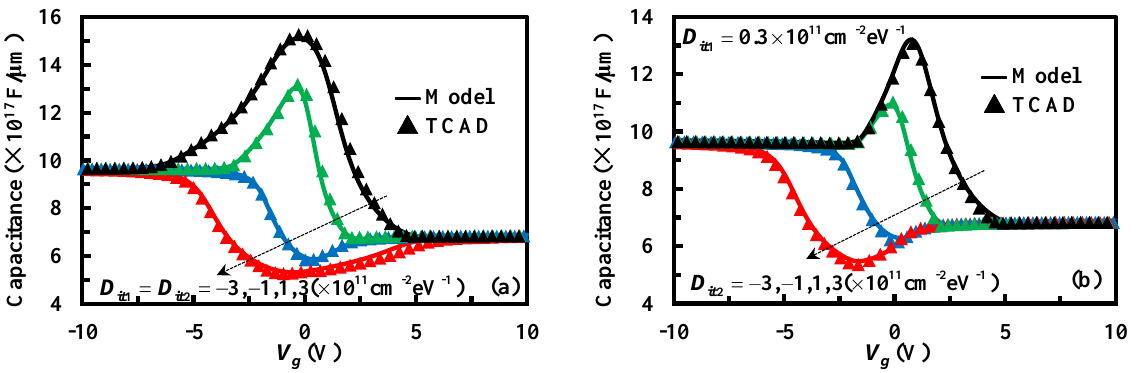
Figure 9. Under different interface-trap densities, high-frequency capacitance–voltage characteristics of the staked bonding structure: ( a ) D it 1 = D it 2 , ( b ) D it 1 (cid:54) = D it 2 . Figure 10 shows the extraction results of D it 1,2 . The x-axis represents D it 1,2 obtained by TCAD simulation, and the y-axis represents D it 1,2 extracted by the proposed extraction method. The distance between the dots and diagonal line illustrates the accuracy of the extraction results. It can be seen from the figure that the dots are concentrated near the diagonal line, which verifies that this extraction method is accurate and independent of various high-frequency capacitance voltage curves.